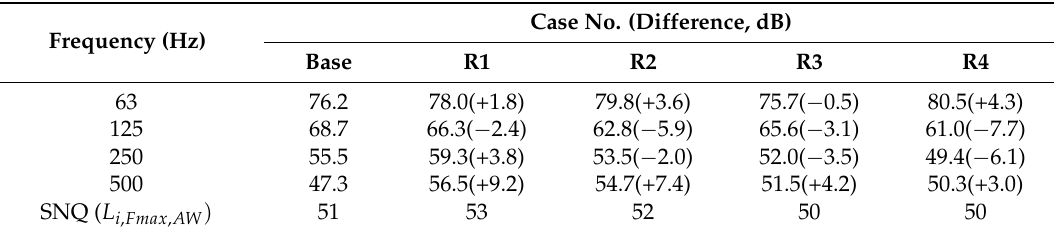
Table 16. Bang machine’s test results in 1/1 Octave